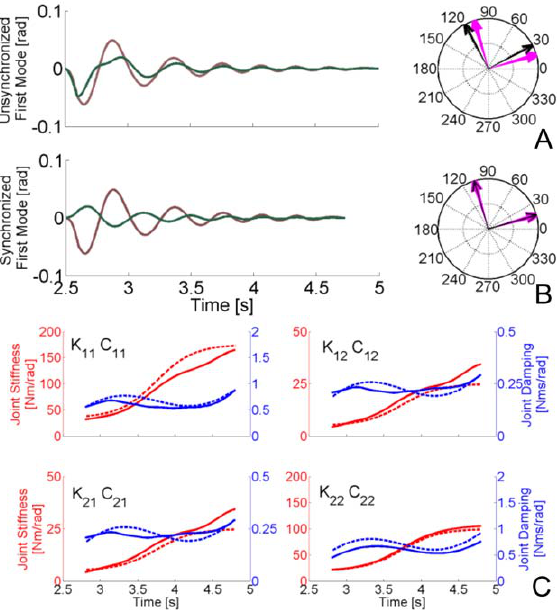
Figure 11. Mode Synchronization and parameter estimation with complex modes. A) LEFT: unsynchronized first mode. RIGHT: imposed (Magenta) vs. estimated (Black) eigenvectors using unsyn- chronized modes. The error is equal to half the rotation imposed on the damping matrix to simulate non-classical damping. B) Synchronized modes and eigenvector respectively. C) Estimation of stiffness and damping for a sigmoid-sinlin Stiffness-Damping time-profile, when signals are corrupted with signal dependent noise.